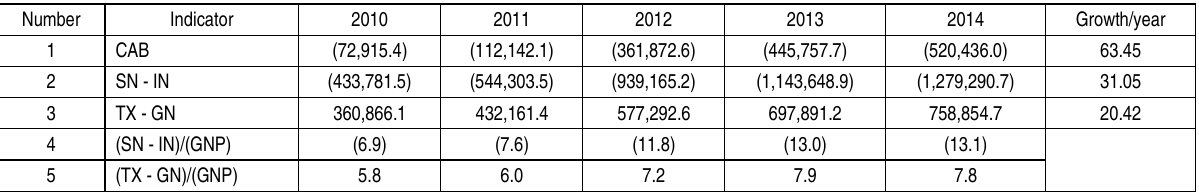
Table 3. Private savings, private investments, tax, expenditures and current account balance in Indonesia in 2010-2014 (billion